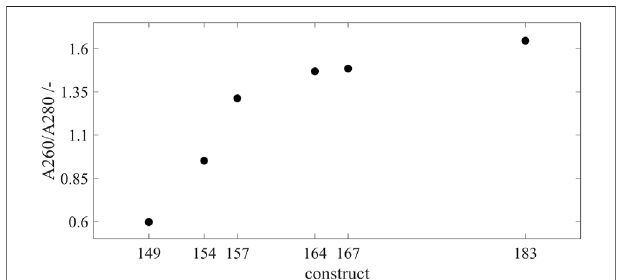
FIGURE 4 | Loading of the VLP capsids with host cell-derived nucleic acids for all constructs. SEC chromatography was used to evaluate the loading of the puri fi ed VLP capsids by A260/A280 coef fi cient after scatter correction (Porter fi eld and Zlotnick, 2010). For every construct, samples were analyzed by SEC in triplicates, respectively. Error bars are negligible and therefore omitted. Details on capsid peak identi fi cation can be found in Supplementary Material S2 ; VLP, virus-like particle; SEC, size-exclusion chromatography.